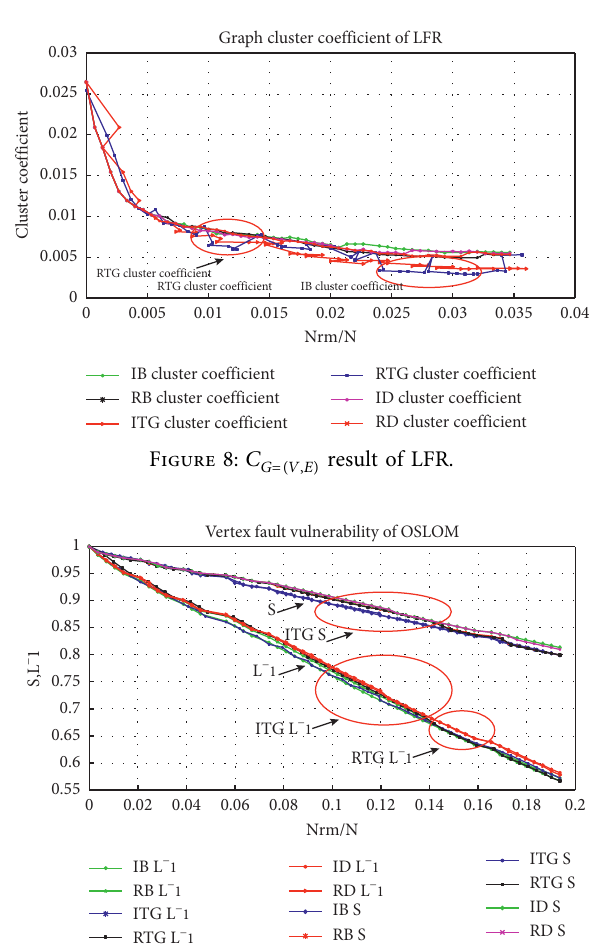
Figure 9: l − 1 & S result of OSLOM.